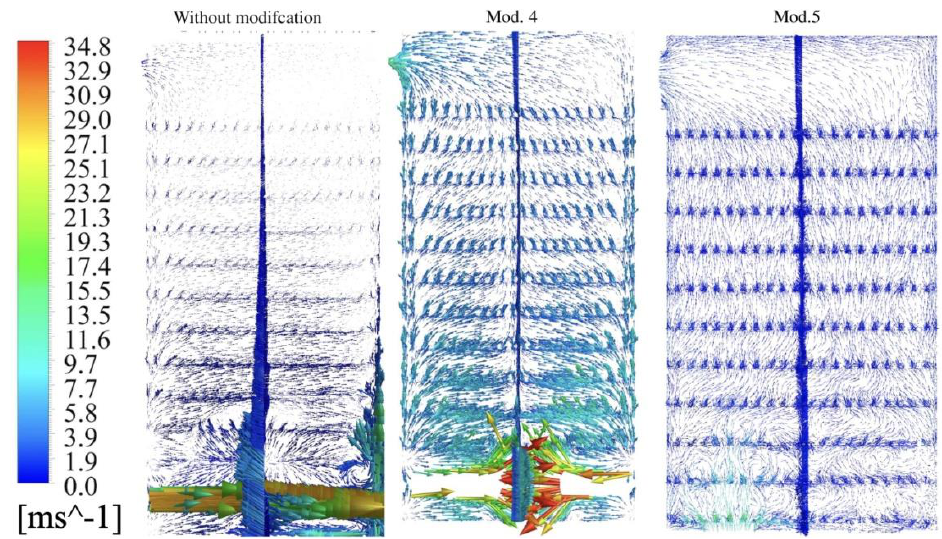
Figure 6. Visualization of velocity vectors-comparison of 3 chambers.